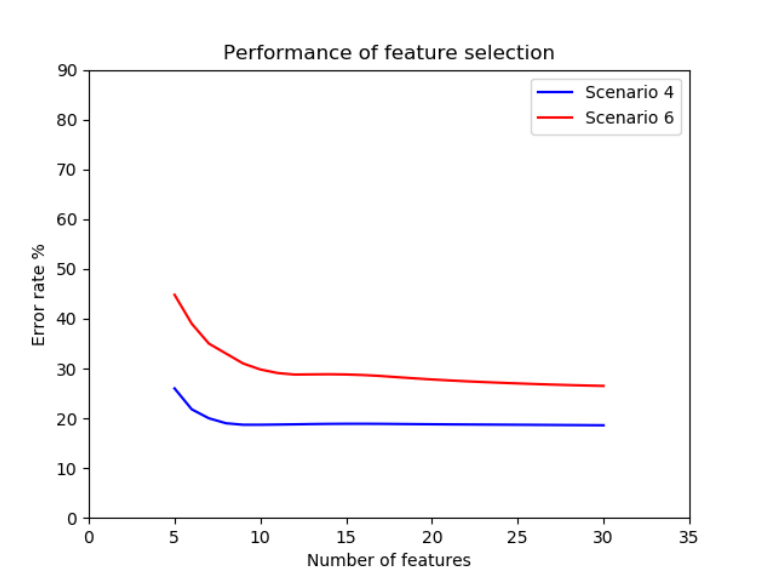
Figure 5. Performance of feature selection for scenarios 4 and